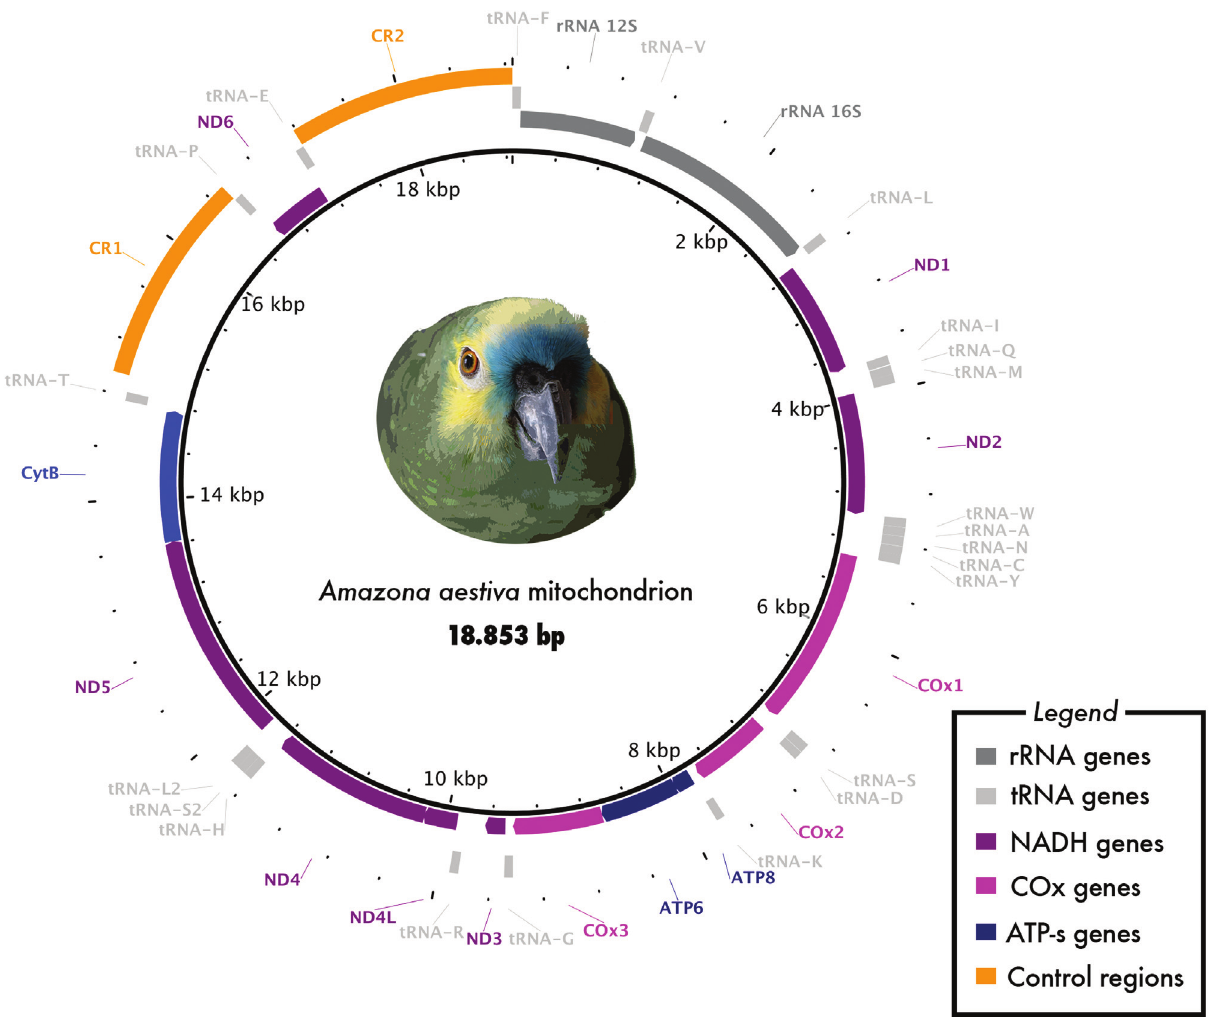
Figure 1 - Mitochondrial genome of Amazona aestiva . Major genomic features are shown. Colors follow the legend